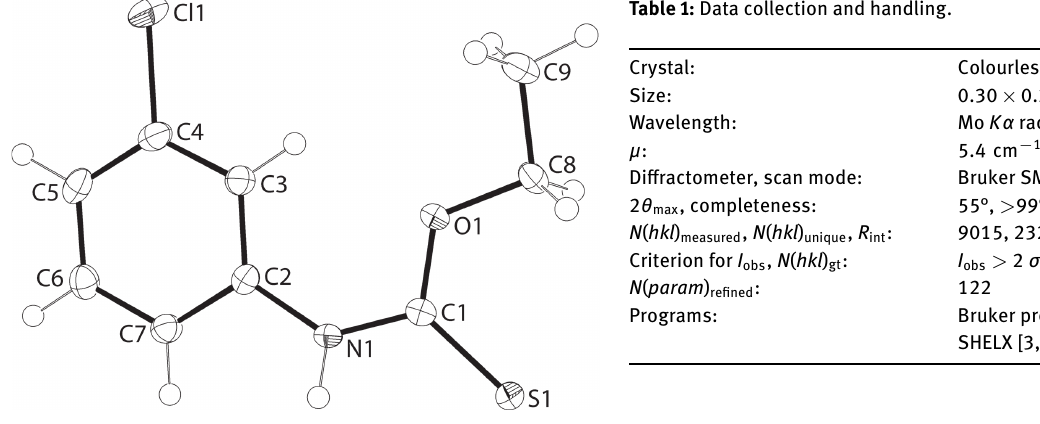
Table 2: Fractional atomic coordinates and isotropic or equivalent isotropic displacement parameters (Å 2